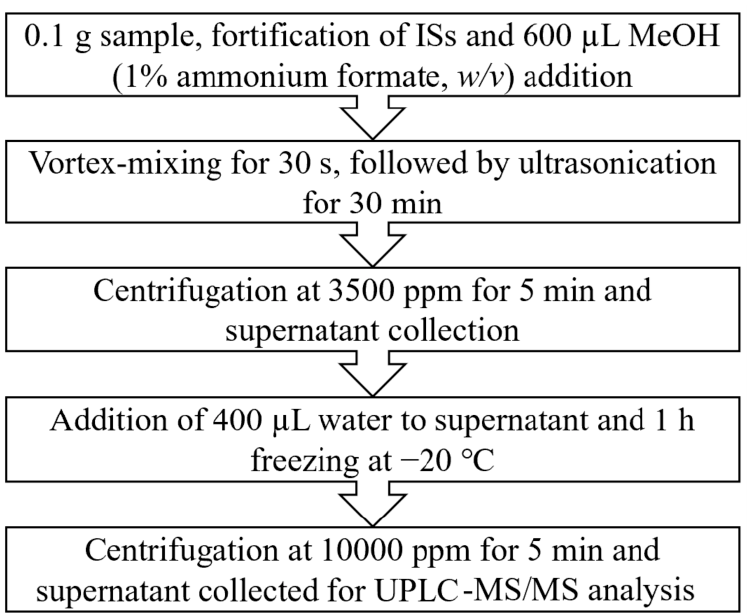
Figure 1. Sample preparation workflow.